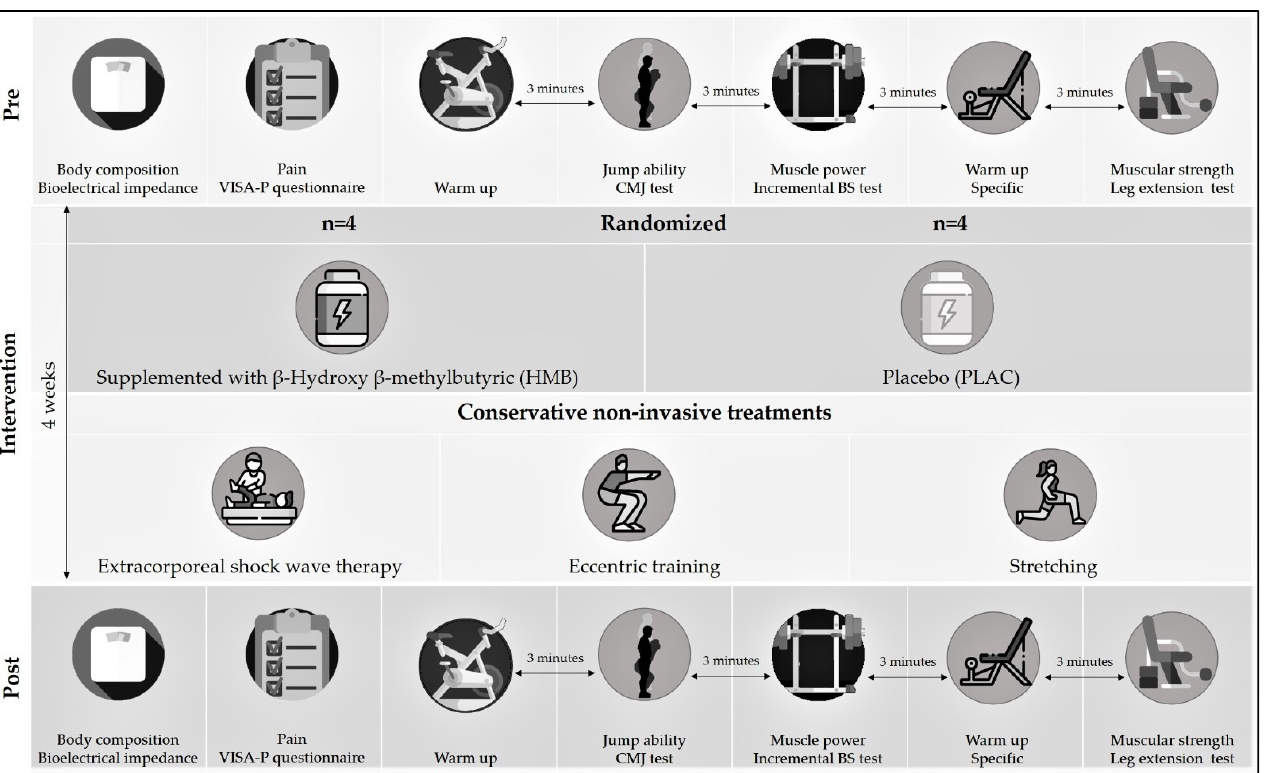
Figure 1. Experimental design.